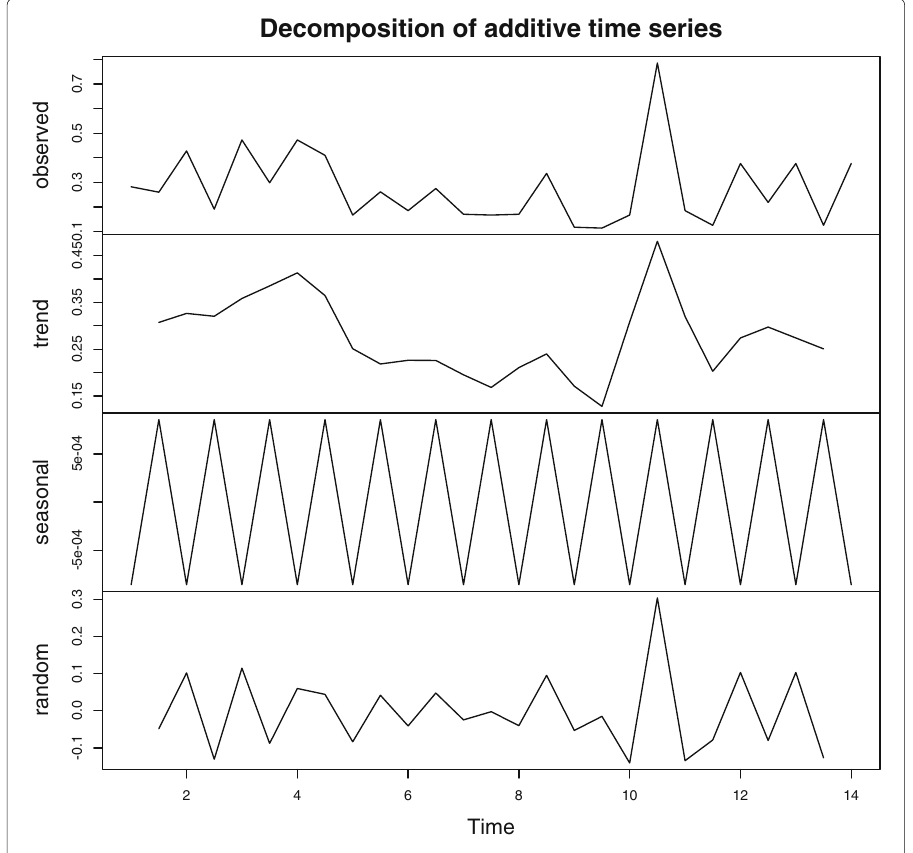
Fig. 3 Observed local clustering coefficient of the nodes on a referral path, and the three components parsed into their time series decomposition. The seasonal component fluctuates along the time